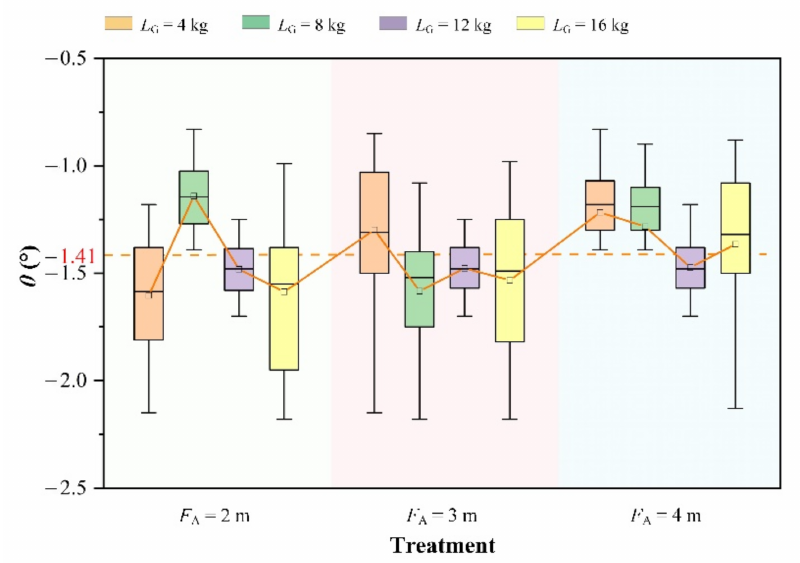
Figure 9. Box chart of measured pitch angle values in hovering of the UAV sprayer. The total mean value of the pitch angle is presented based on the mean value of all the treatments with different loads ( L G = 4, 8, 12, and 16 kg) and flight altitudes ( F A = 2, 3, and 4